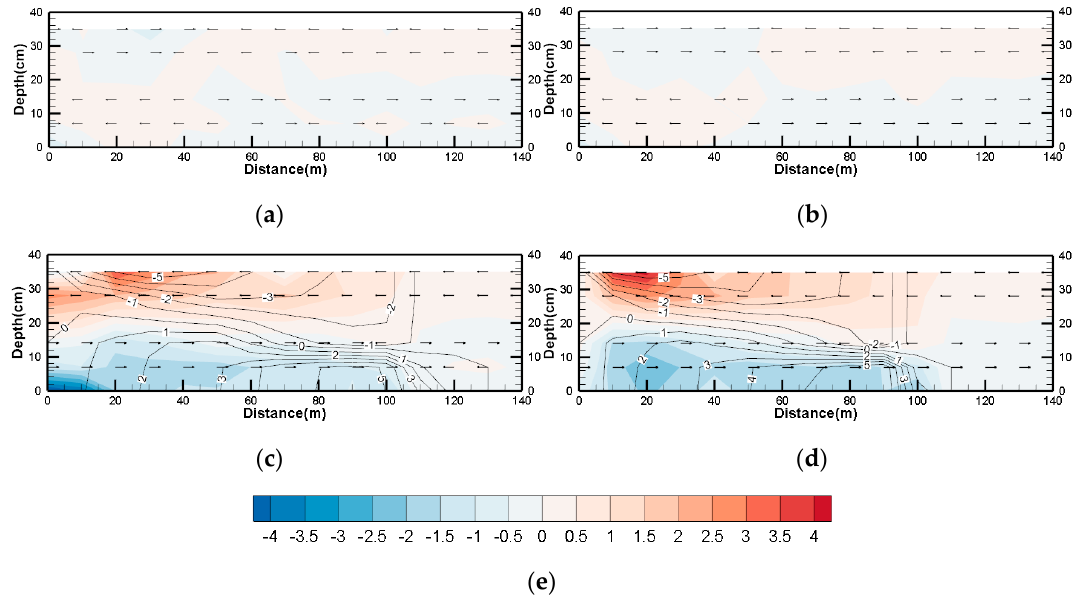
Figure 10. Gravitational circulation profiles. ( a ) The dynamic conditions of fresh water test were the same as those of Case 1, but there was no salt added into the test water; ( b ) The dynamic conditions of fresh water test were the same as those of Case 2; ( c ) Case 1; ( d ) Case 2; ( e ) Legend of velocity (unit: cm/s). The arrow represents the flow direction. The contour represents the